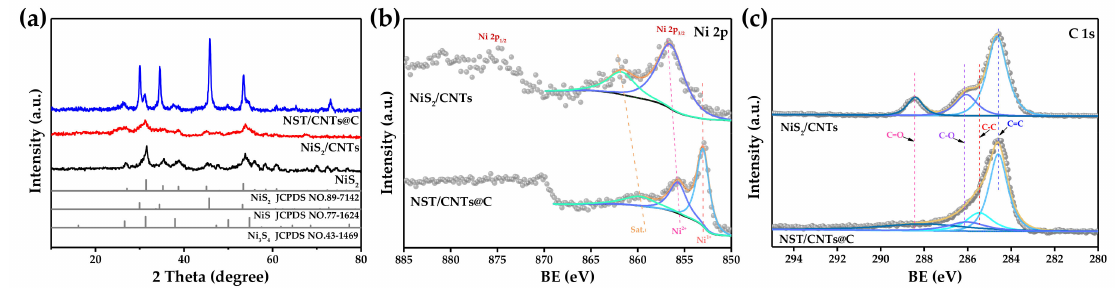
Figure 2. ( a ) X-ray di ff raction patterns of three electrode materials; XPS spectra for ( b ) Ni 2p and ( c ) C 1s of NiS 2 / CNTs and NST /